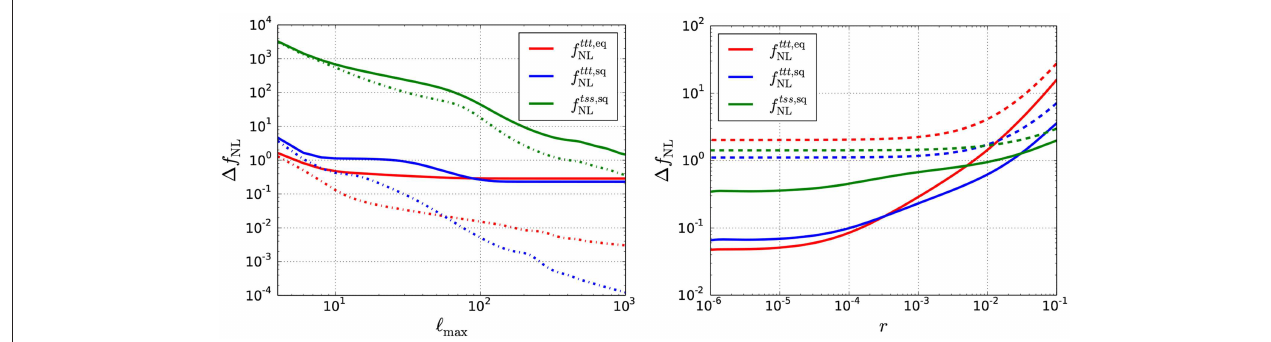
FIGURE 2 | Expected 1 σ errors: 1 f ttt ,eq NL (red lines) and 1 f ttt ,sq NL (blue lines) from BBB , and 1 f tss ,sq NL (green lines) from BTT , as a function of the maximum multipole number ℓ max (left panel) and the tensor-to-scalar ratio r (right panel). The left panel is depicted adopting r ℓ max 2000. The linestyle discriminates the cleanliness level of the B-mode data: a perfectly-delensed and noiseless full-sky case (dot-dashed lines in left panel), a = non-delensed and noiseless full-sky one (solid lines in both panels), and a LiteBIRD-like realistic one (dashed lines in right